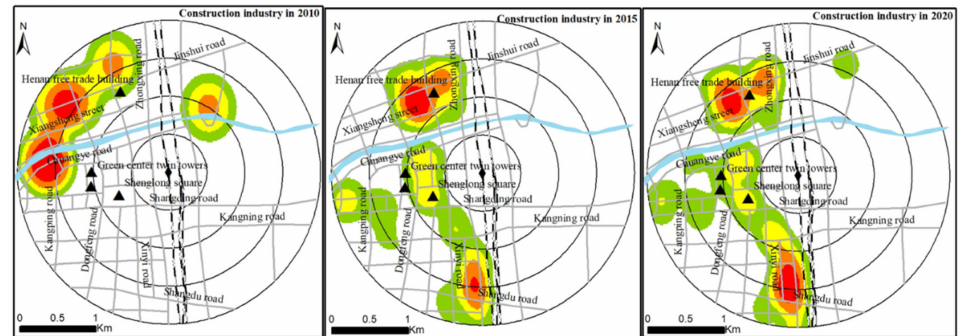
Figure 4. Kernel density analysis of the construction